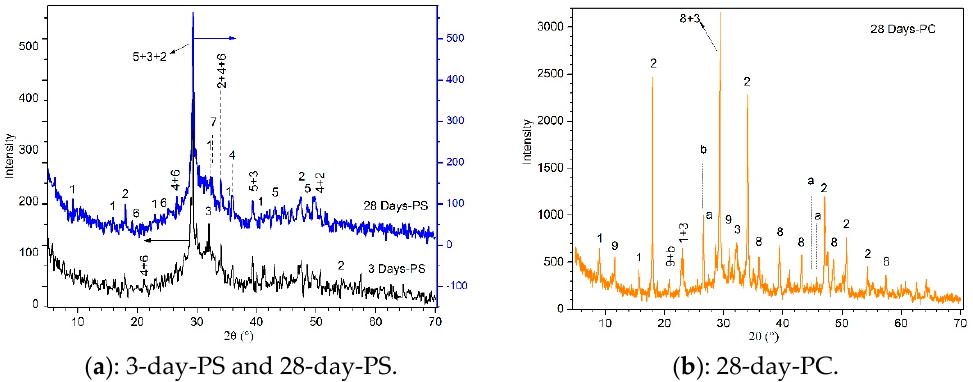
Figure 5. X-ray Diffraction (XRD) patterns of leaded solidified samples at different hydration ages. 1- Figure 5. X-ray Di ff raction (XRD) patterns of leaded solidified samples at di ff erent hydration Ettringite, 2-Portlandite, 3-Calcium Silicate Hydrate, 4-Lead carbonate hydroxide hydrate, 5-Calcite, 6-Hydrocerussite, 7-Larnite, 8-Calcite, 9-Gypsum, a-Lead Hydroxide, b-Quartz. ( a ): 3-day-PS and 28- day-PS, ( b ): 28-day-PC.